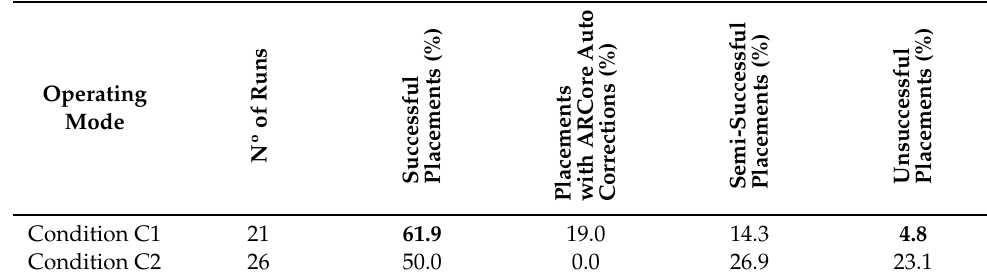
Table 1. Comparison between the two conditions: C1—motion tracking using cloud anchors; C2— offline motion tracking. Results from 20 participants, half using operating mode C1 and the remaining half adopting operating mode